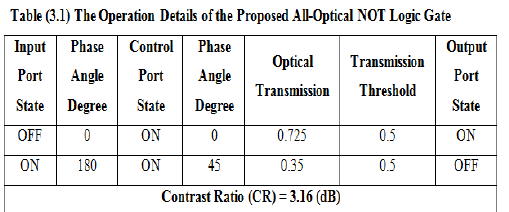
Figure 4: Optical Transmission as a Function of Wavelength at the Different Condition States. Table 1: The realization details of the proposed all- optical NOT logic